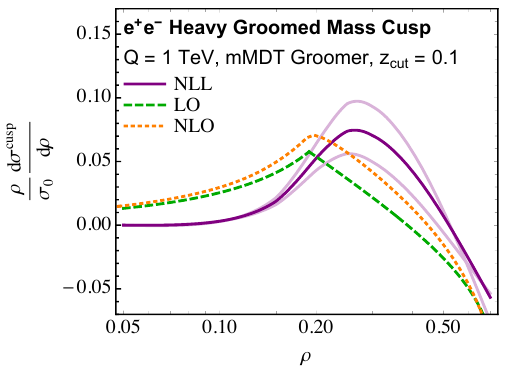
Figure 6 . Comparison of the NLL cusp resummation to the cusp at leading- and next-to-leading fixed order in e + e − collisions at 1 TeV. The darker NLL distribution uses canonical scales, while the lighter curves below (above) vary the scale of the soft function up (down) by a factor of 2.